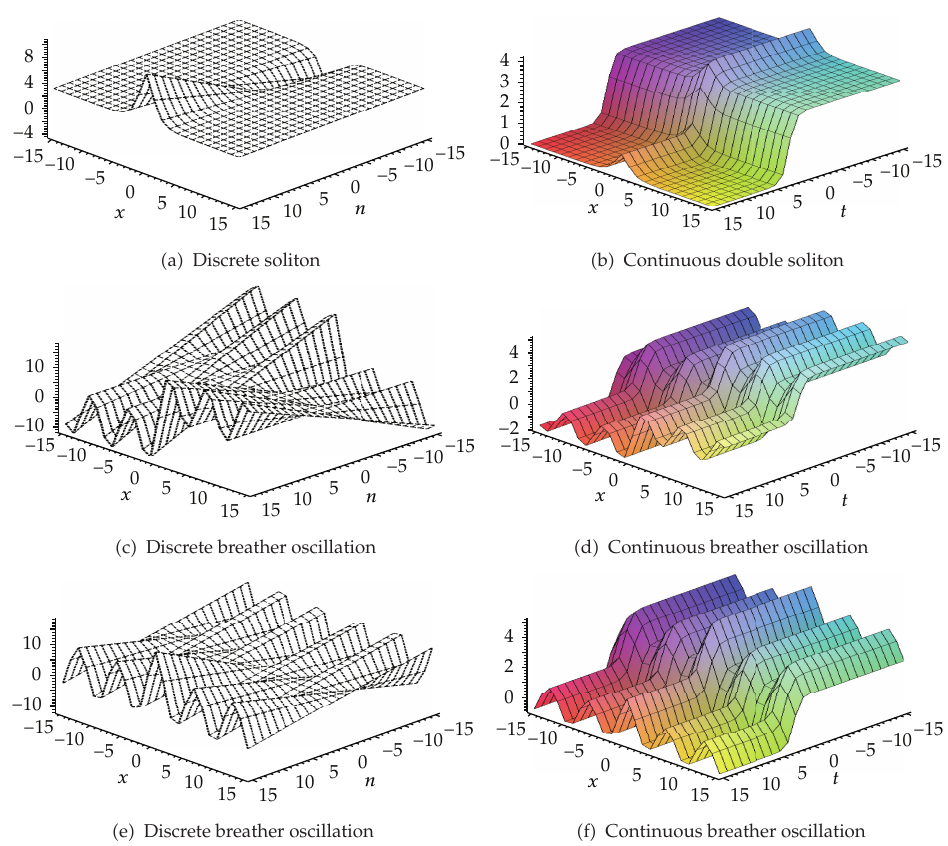
Figure 3: The solutions u n in (cid:2) 3.31 (cid:4) , (cid:2) 3.34 (cid:4) , and (cid:2) 3.35 (cid:4) show six shapes of discrete and continuous solitons and discrete and continuous breather